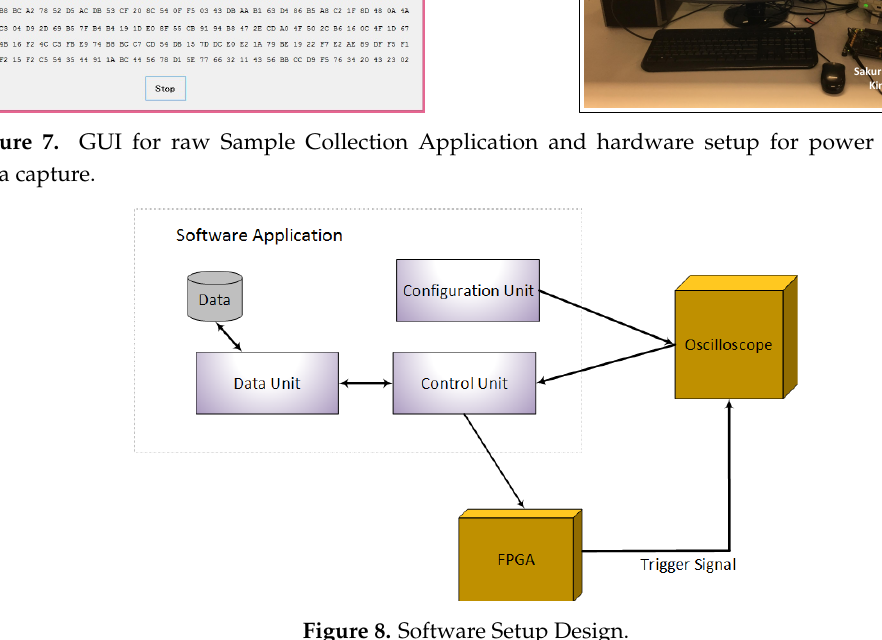
Figure 8. Software Setup